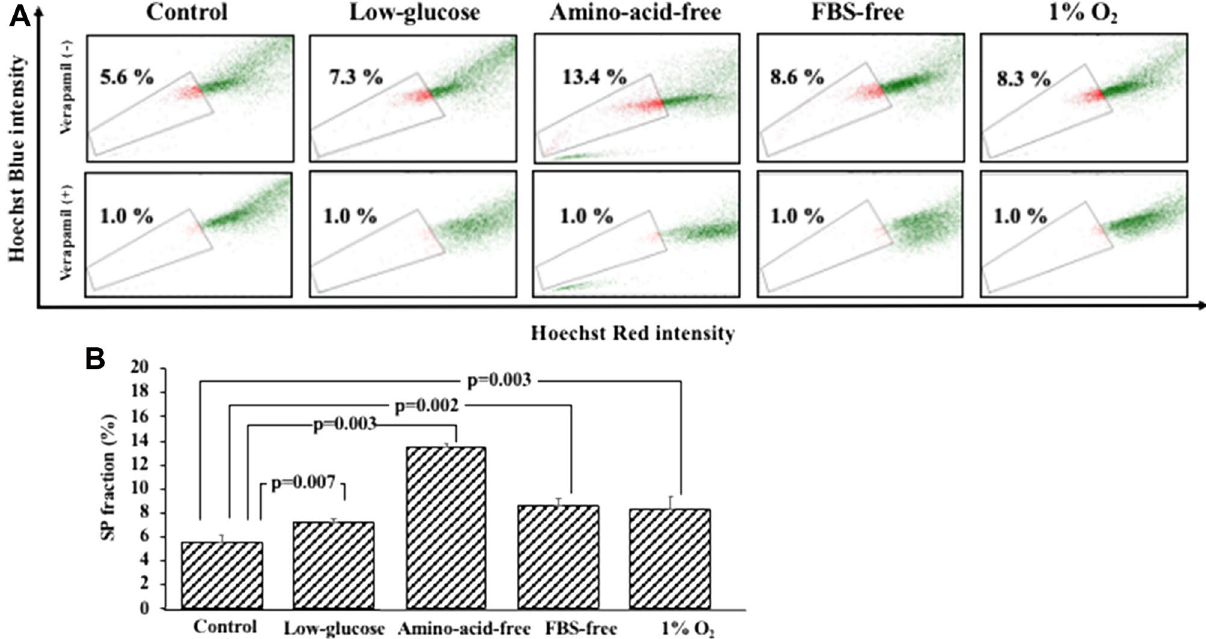
Figure 4. The SP fraction under starvation and hypoxic stress. ( A ) Representative picture of SP fraction under starvation and hypoxic stress. ( B ) The SP fraction was significantly high under starvation stress and hypoxic stress in comparison to the parent cells. The SP fractions under the low-glucose-medium, amino-acid-free medium, FBS-free medium, and 1%O 2 conditions were 7.3 ± 0.2% (p = 0.007), 13.2 ± 0.4% (p = 0.003), 7.9 ± 0.7% (p = 0.002), and 7.7 ± 1.0% (p = 0.003) in comparison to the parent cells, erspectively.